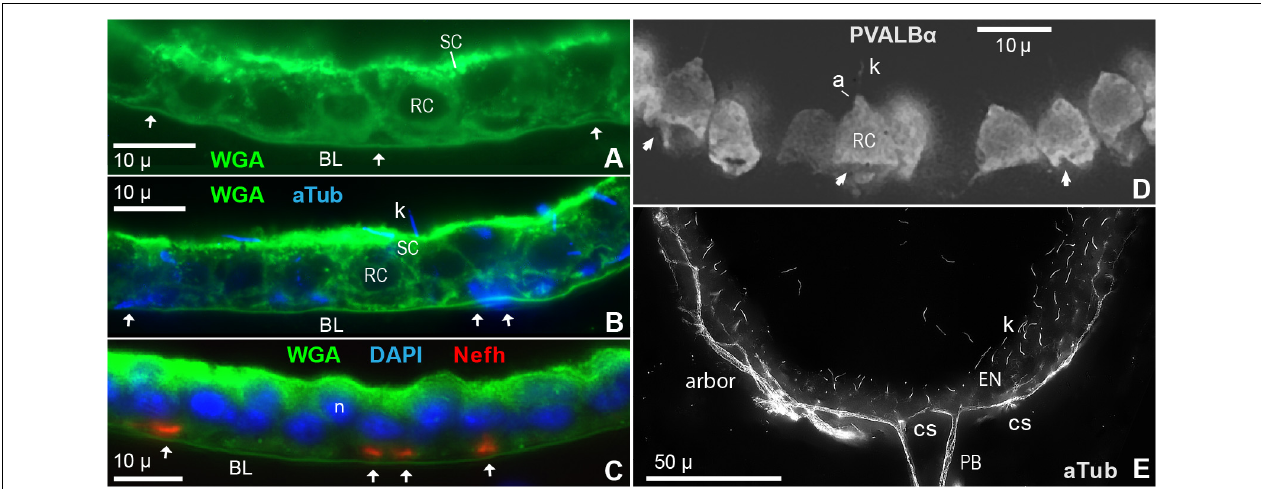
FIGURE 6 | Innervation of electrosensory neuroepithelia (EN). (A–C) Cross sections (12 µ ) of EN showed unmyelinated afferent arbors occupying triangular basal spaces (arrows) distal to the basal lamina labeled by wheat germ agglutinin (WGA). See keys for labels. RC, Receptor cell. SC, Support cell. (A) Basal spaces are marked by arrows; 100x 1.25 NA lens. (B) Co-labeling showed that cross-cut afferents labeled by anti–aTub (blue) occupied the basal spaces (arrows); 100x 1.25 NA lens. Anti–aTub also labeled kinocilia (k) on receptor cells. (C) Co-labeling showed that cross-cut afferents labeled by anti–Nefh (orange) occupied the basal spaces (arrows); 40x 0.7 NA lens. Nuclei (n) of receptor cells (lower) and support cells (upper) were stained by DAPI. (D) Instead of being rounded as expected, the basal poles of many receptor cells (RC), labeled by anti–parvalbumin- α ( Table 1 ), were indented, furrowed, or distorted (arrows), likely by passing trunks of afferent neurites; 60x 1.4 NA lens. a, Apical pyramid on RC. k, Kinocilium on RC. (E) Fascicles of projection fibers (PB) approached the basal face of an EN at contact sites (cs), then ramified laterally (arbor); 60x 1.4 NA lens, 0.25 µ stack step size. The calculated optical lateral resolution for this image of anti–aTub blue fluorescence was ∼ 0.2 µ (Rayleigh criterion) to ∼ 0.3 µ (for three camera